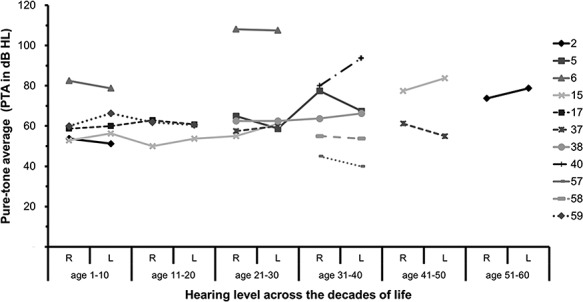
Degree and progression of hearing loss in USH2A patients. Pure tone average (PTA) measurements (decibel hearing loss, dB HL) from right (R) and left (L) ears of USH2A patients obtained within different decades of lifetime. Color key corresponds to patient number.